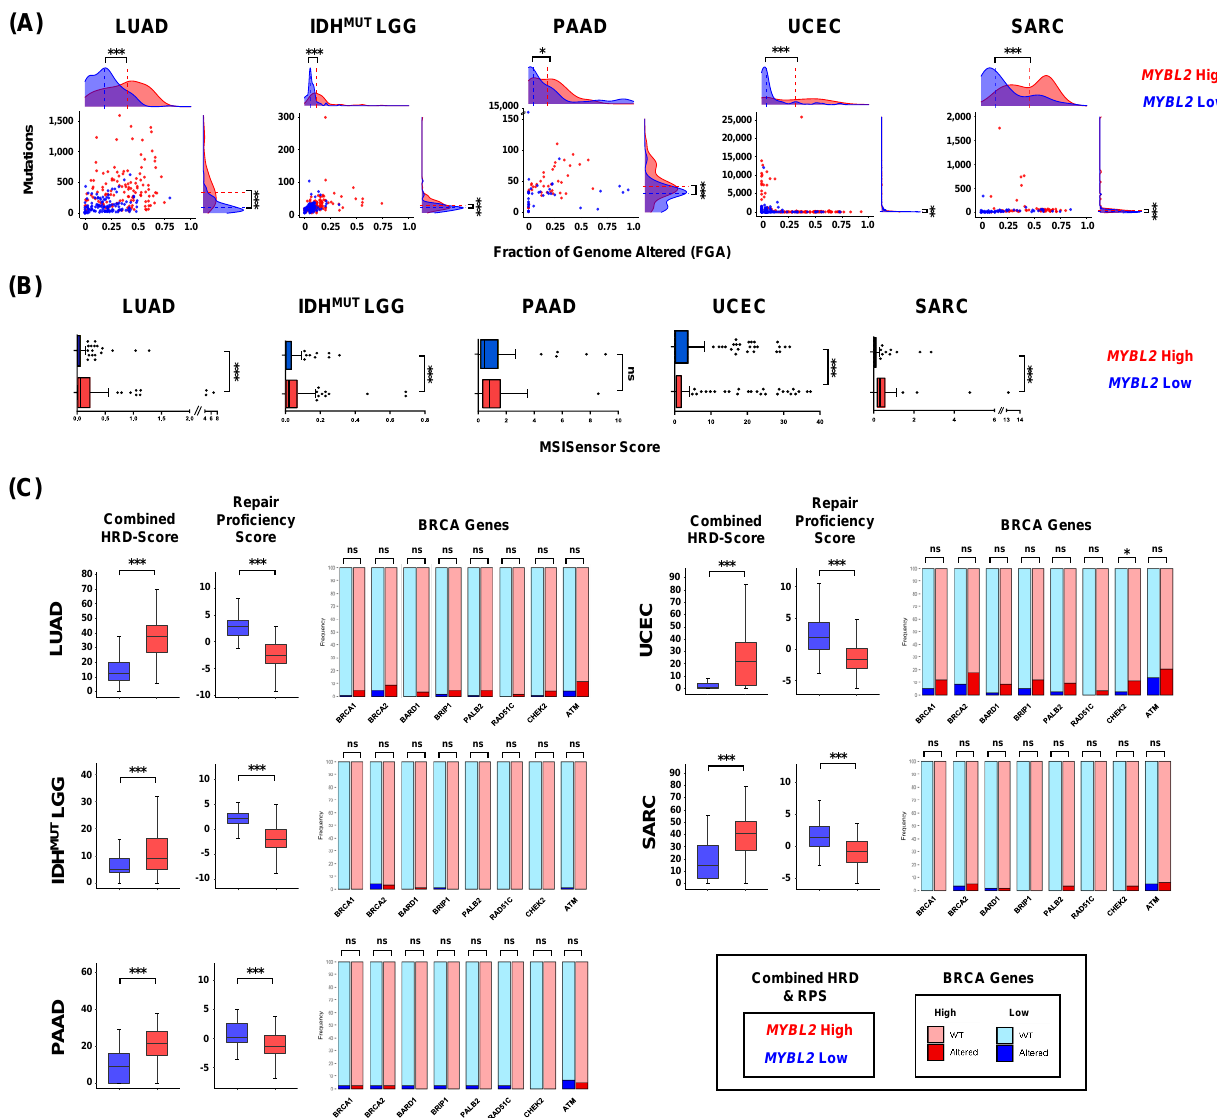
and PFS outcomes. Log-rank test p -values are displayed. ( C ) MYBL2 High tumors develop across common cancer genetic driver backgrounds. Percentages reflect the percent of tumors with gene spe- cific alterations. Statistical significance mapping represents Benjamini-Hochberg corrected q values, q < 0.05 *, q < 0.001 ***. ( D ) Individual tumors show different patterns of tumor suppressor inactiva- tion and oncogene activation with respect to MYBL2 High and MYBL2 Low disease. IDH MUT LGG tumor suppressor and oncogene status were mapped excluding founding IDH mutations. One-sided Fisher’s exact test, p < 0.05 *, p < 0.01 **, ns: not significant. LUAD: lung adenocarcinoma. IDH MUT LGG: IDH-mutant lower grade glioma. PAAD: pancreatic adenocarcinoma. UCEC: uterine corpus endometrial carcinoma. SARC: sarcoma.